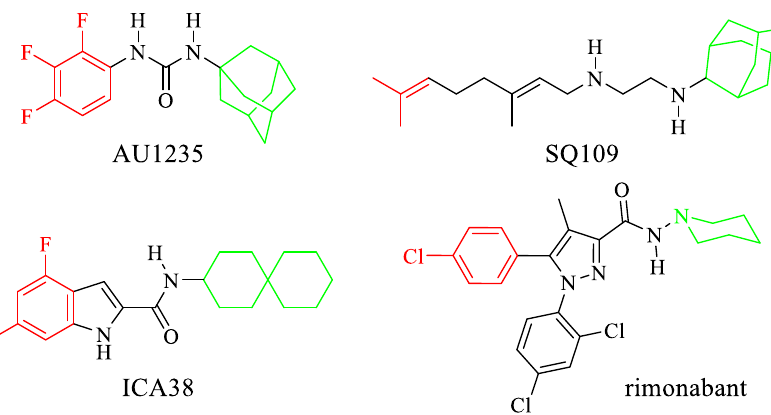
Figure 1. Structure of the MmpL3 inhibitors used to build the pharmacophoric model. The tri- fluorophenyl moiety of AU1235, the difluorophenyl moiety of ICA38, the terminal alkenyl edge of SQ109, and the 5-chlorophenyl moiety of rimonabant are represented in red. The adamantyl moiety of both AU1235 and SQ109, the spiro-undecane moiety of ICA38, and the piperidine ring of rimonabant are represented in green.